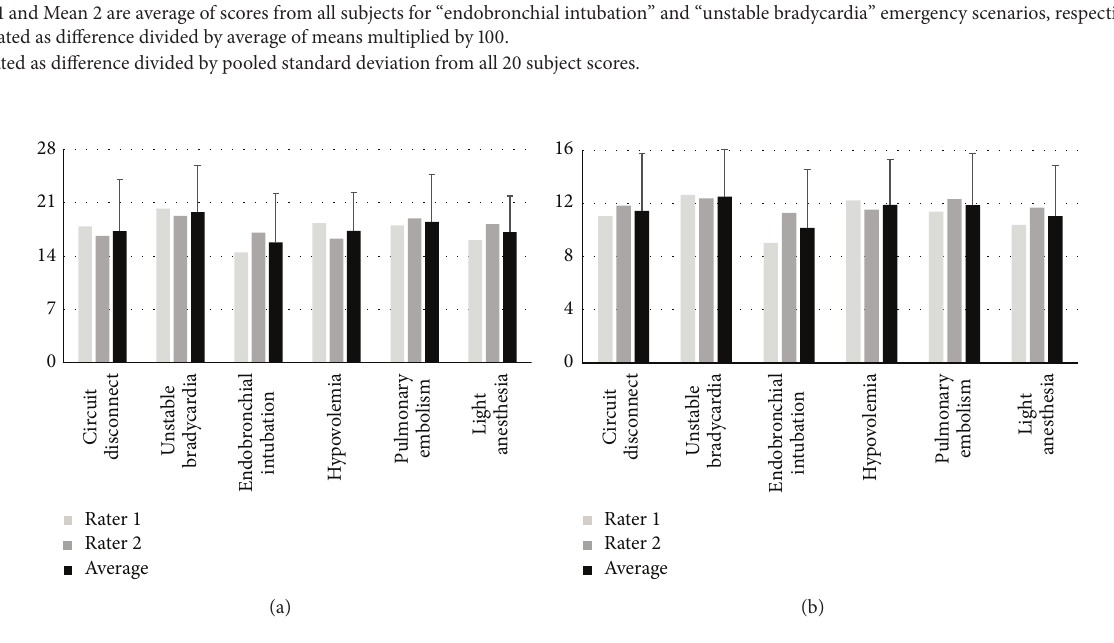
Figure 6: Subject performance assessment scores from the Global Rating Scale (a) and Crisis Management Checklist (b) based on emergency scenario. Individual rater and average ratings are shown. The bars depict standard